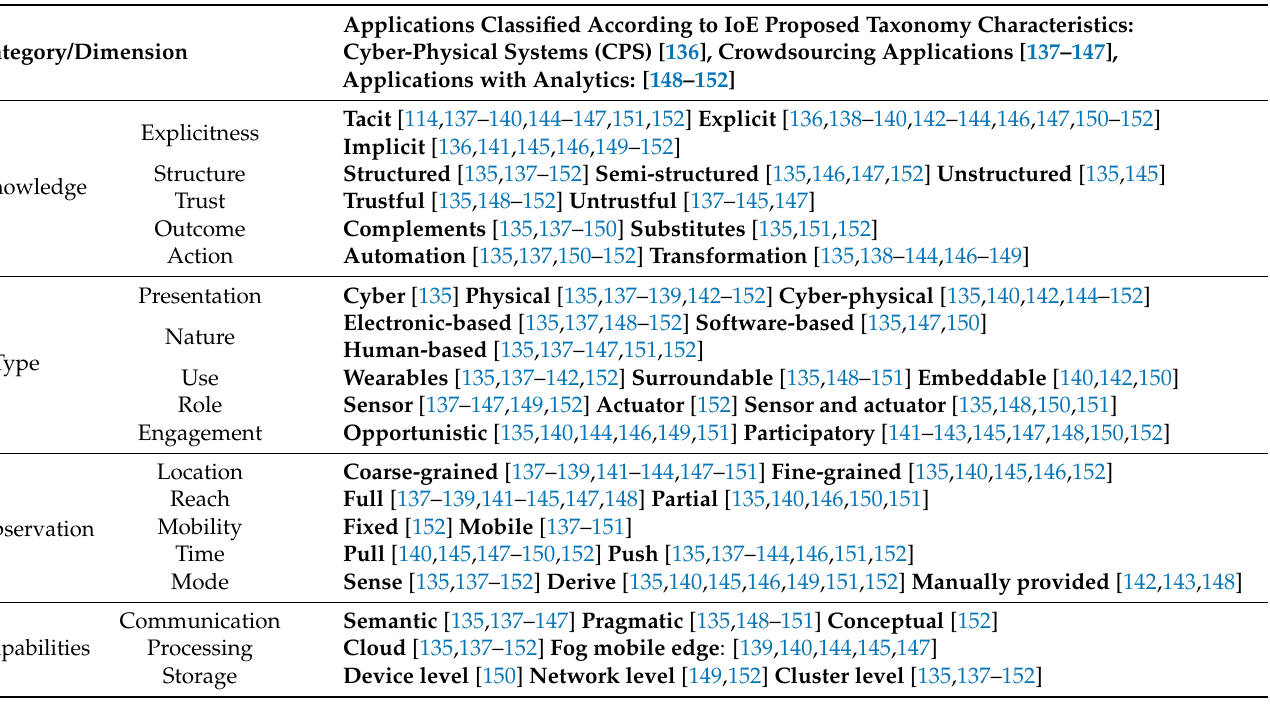
Table 3. Validation of proposed IoE taxonomy in distinct